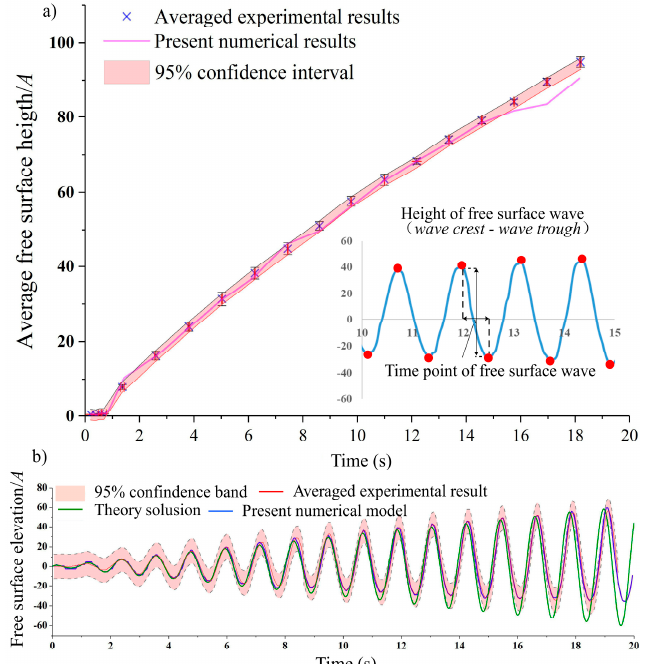
Figure 3. The validation of the present numerical model with experimental tests [19] and theoretical solution [32], ω / ω 1 = 0.996, A / L = 0.0025, d / L = 0.5. ( a ) Uncertainty analysis of three experimental tests, the error bars indicated a Standard Error of time (X-error) and height (Y-error) of the free surface wave. ( b ) Red shallow area represented the prediction limit of the average experimental result at a 95% confidence level.